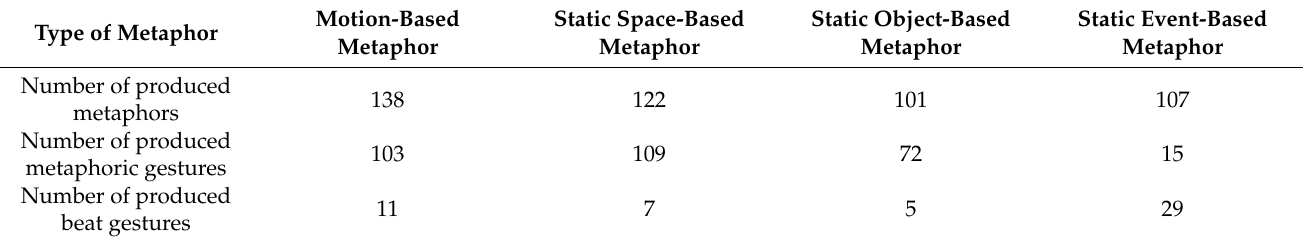
Table 1. Total counts of produced metaphors and accompanying gestures for each type of